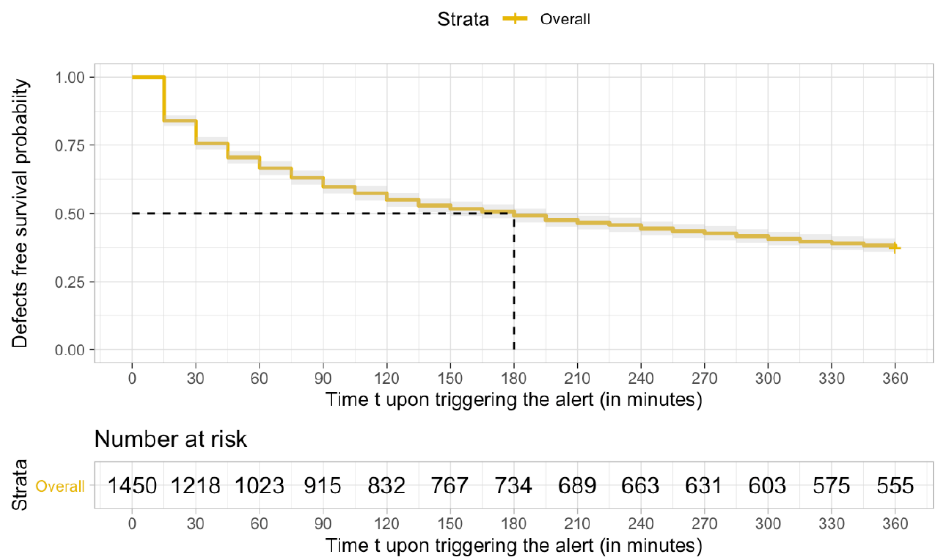
Figure 3. Kaplan–Meier estimates of overall defect free survival probability.